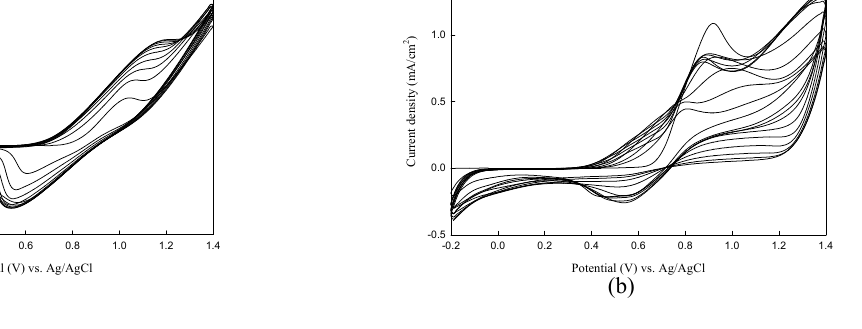
Figure 1. Cont. Figure 1.